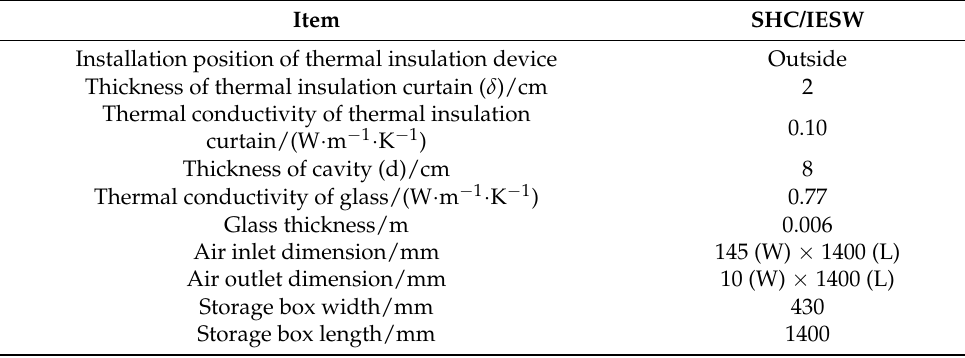
Table 1. Structure parameters of the DSF.